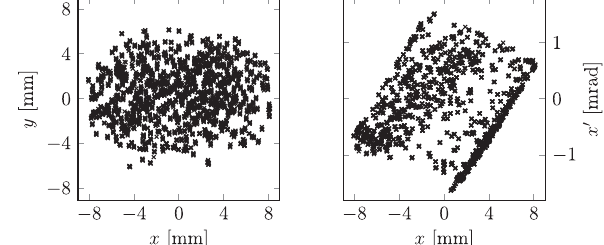
FIG. 5. Schematic drawing of the experimental setup used for the HOM-based cavity misalignment measurement. Eight cavities are located inside one accelerating module, followed by a BPM. The rf is switched off, assuring a drift space between the upstream and downstream BPMs. The beam position and angle at each cavity are calculated from the BPM readings. For each dimension, two steerers are needed in order to get any combi- nation of beam offset and angle at a cavity. Each cavity is equipped with an upstream and a downstream HOM coupler. At each coupler, the signals are filtered, down-converted, and digitized.